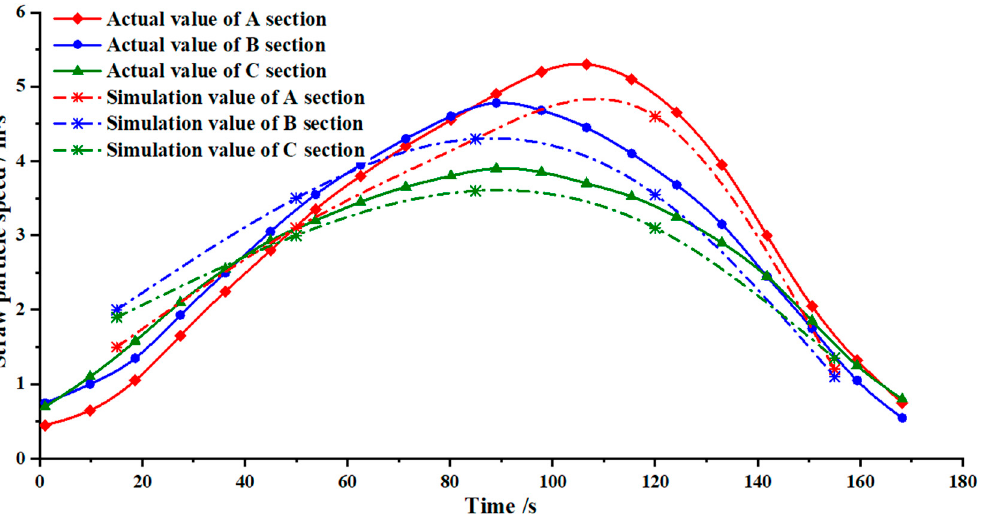
Figure 19. Comparison of the simulation value of the straw scrap speed in the A section, the B sec- tion, and the C section with the measured value of the high-speed camera.